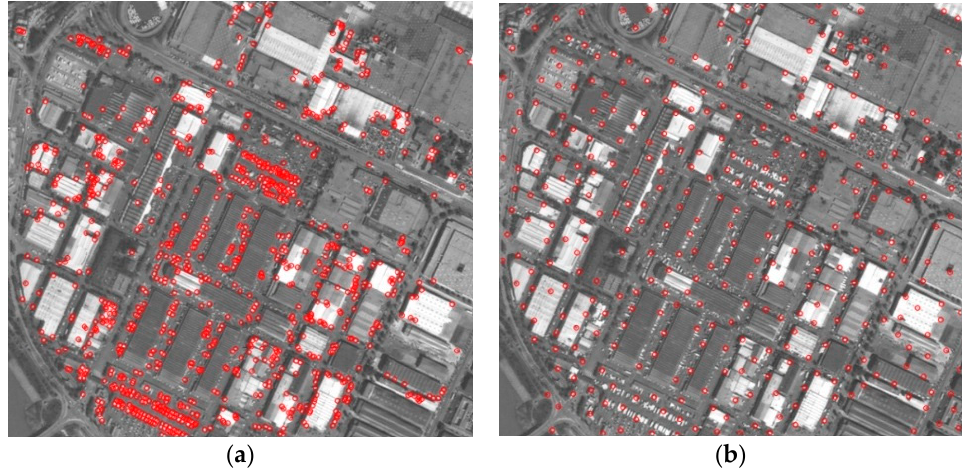
Figure 4. Comparison of standard FAST and UR-FAST. ( a ) Standard FAST and ( b ) UR-FAST.